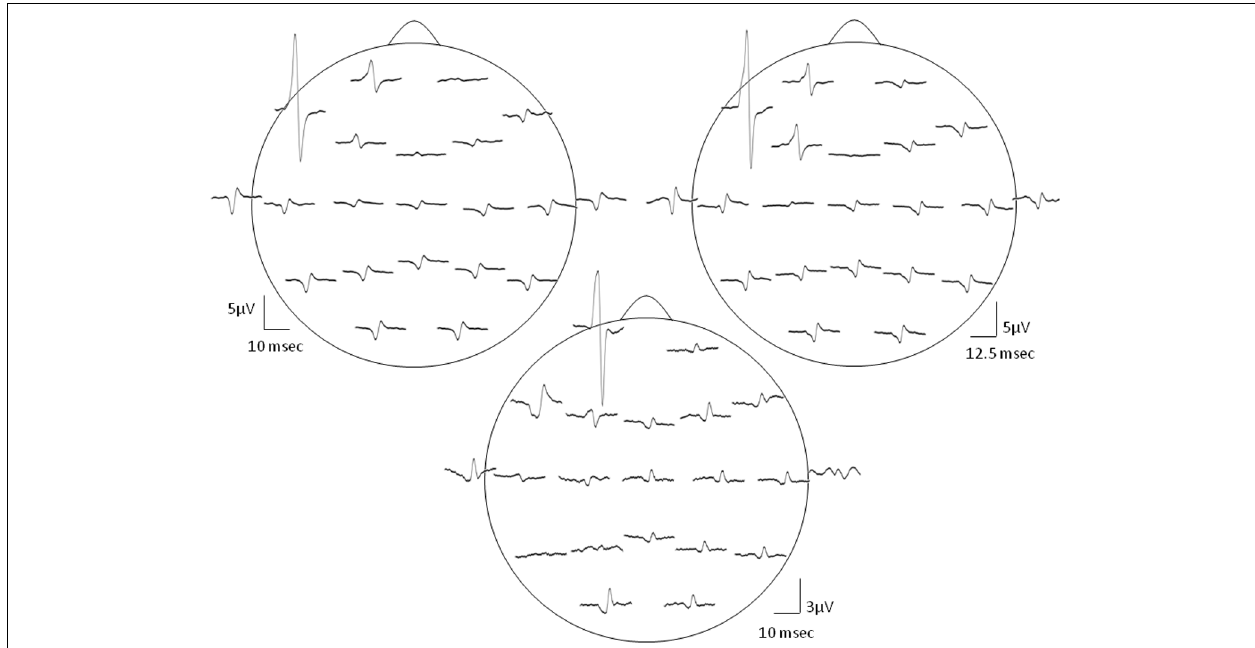
FIGURE 2 | Distribution of the SMU representation in various EEG electrodes. Topography of the Macro-EMEG waveforms of 3 different SMUs is depicted in this figure. In the top two depictions, the largest Macro-EMEG